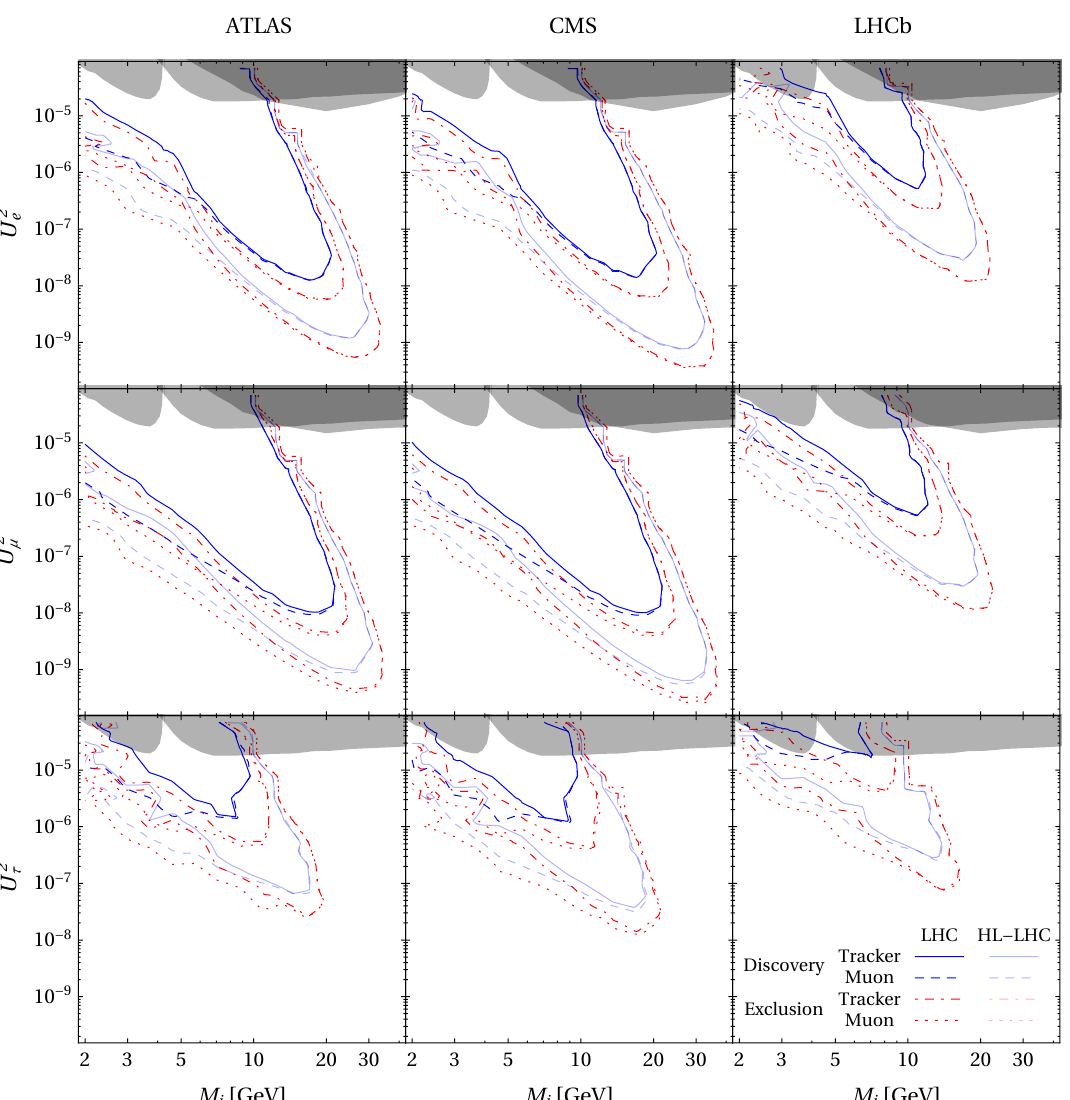
Figure 6. Sensitivity reach of the 13 and 14 TeV LHC. The three columns show the results for ATLAS, CMS and LHCb. The luminosities assumed for CMS and ATLAS are 0.3 and 3 ab (cid:0) 1 and for LHCb are 30 and 380 fb (cid:0) 1 . The three rows constitute the three extreme cases of pure electron, muon and tau coupling, respectively. The blue (red) curves show the discovery (exclusion) potential, both of which are shown for searches using only the tracker and using the tracker together with the muon chamber. For the simulation of LHCb we require decays to happen before or within the (cid:12)rst RICH (cf. also (cid:12)gure 8). The gray bands represent the exclusion bound from DELPHI [52] and CMS [50].